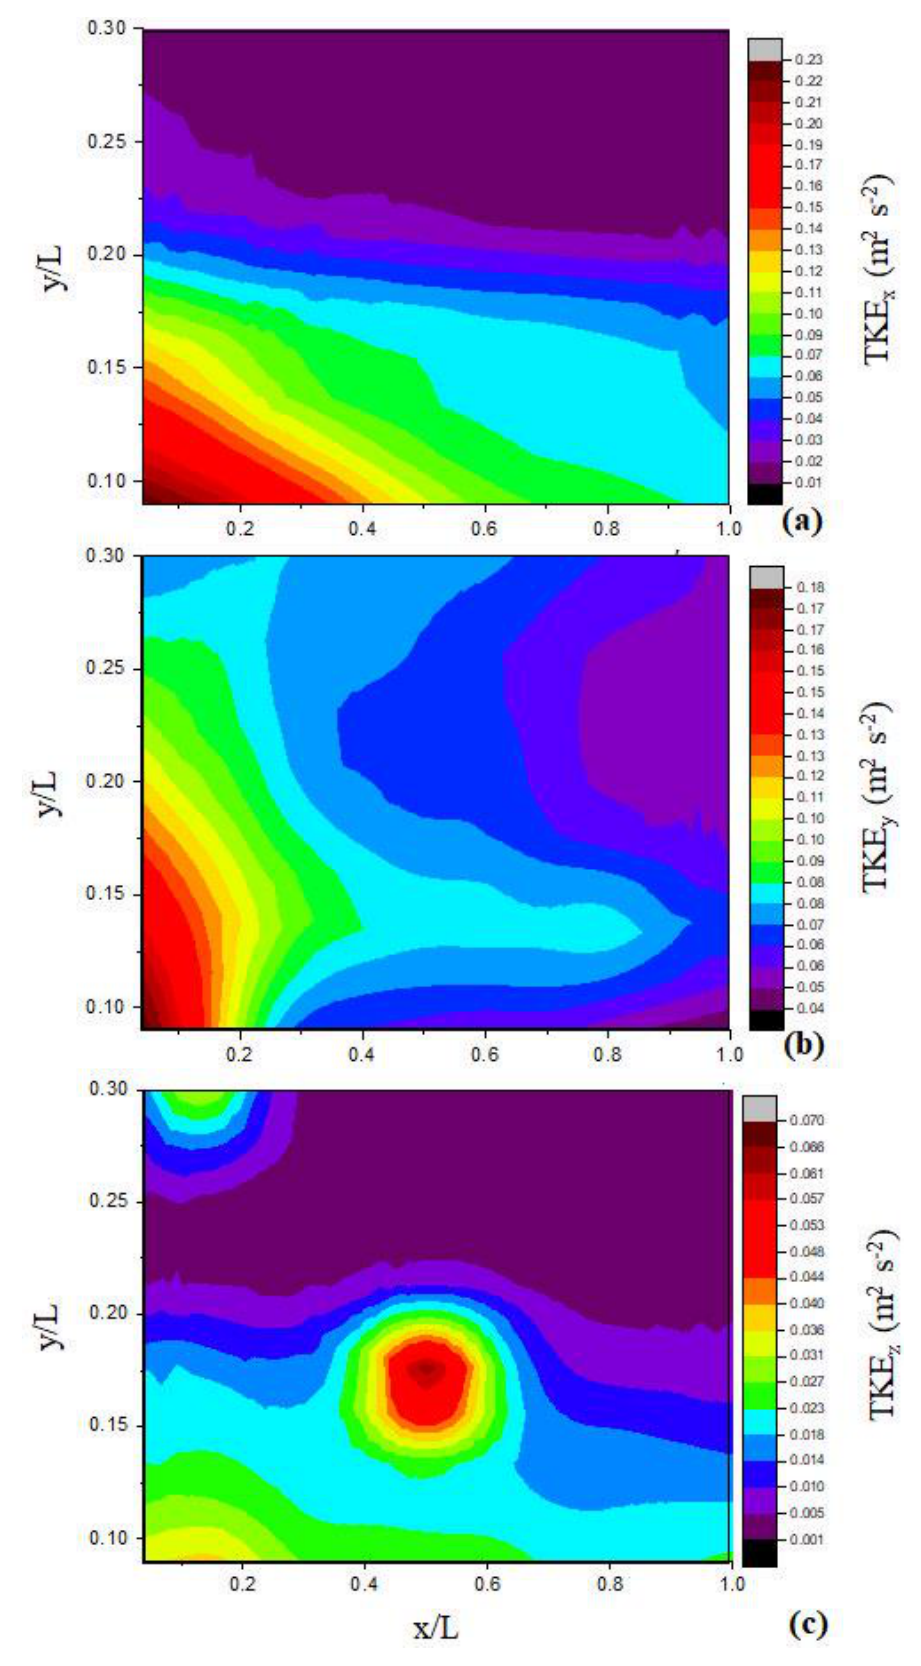
Figure 4. Contour maps of depth-averaged ( a ) TKE x , ( b ) TKE y , and ( c ) TKE z for the experimental run 2R.